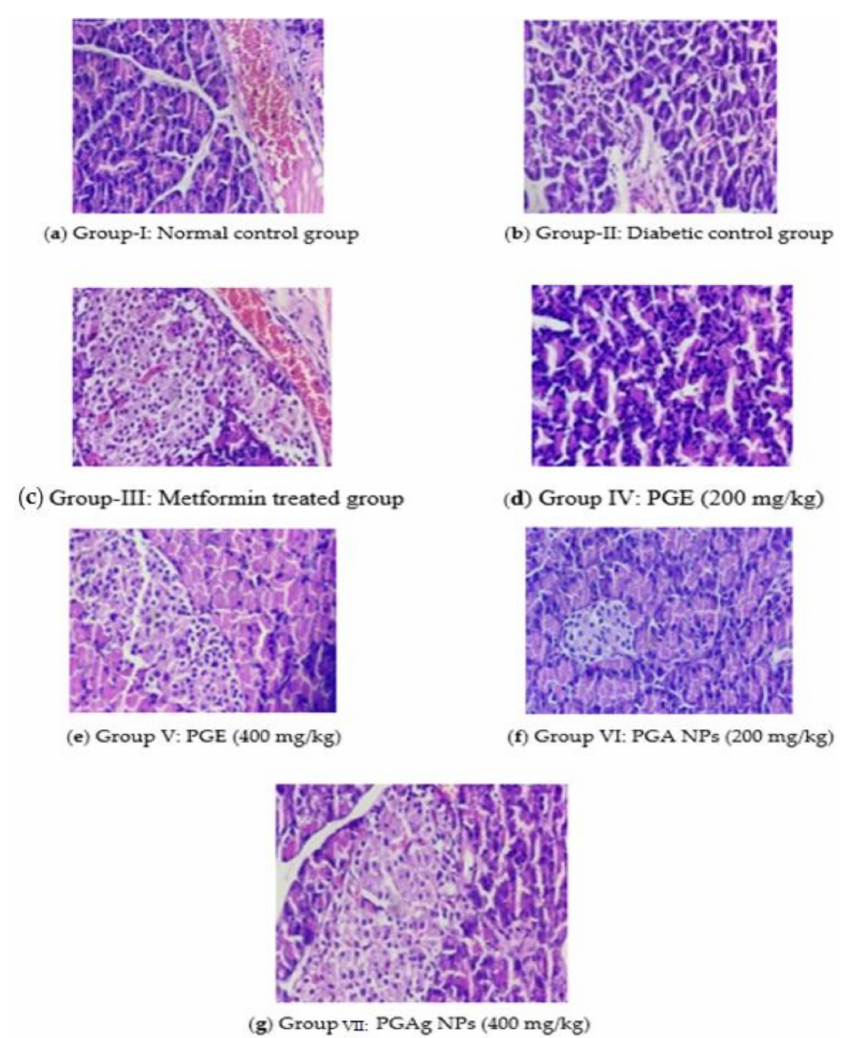
Figure 8. The pancreas section of histology. ( a ) Group I: normal control group; ( b ) Group II: diabetic control group; ( c ) Group III: metformin-treated group; ( d ) Group IV: PGE (200 mg/kg); ( e ) Group V: PGE (400 mg/kg); ( f ) Group VI: PGAg NPs (200 mg/kg); ( g ) Group VII: PGAg NPs (400